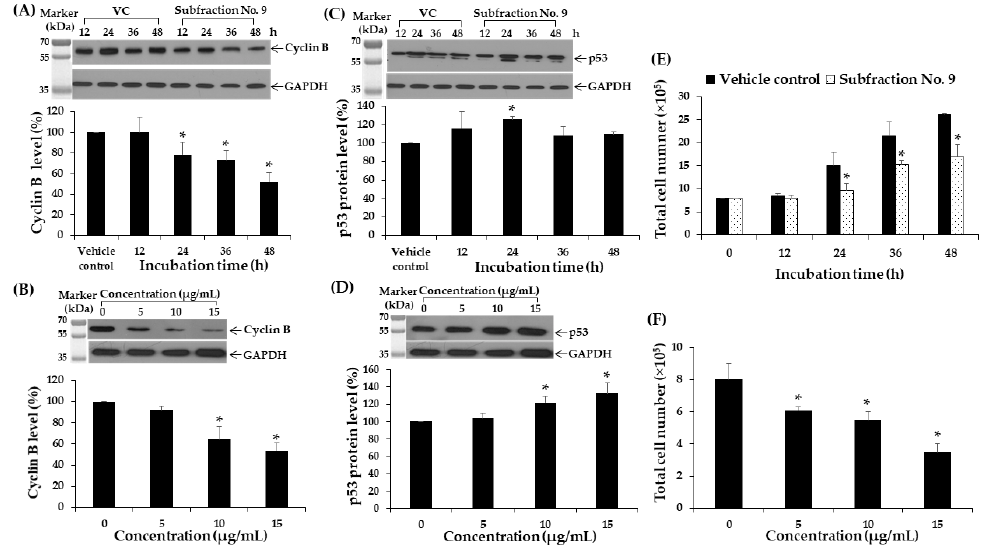
Figure 6. Effects of F9 on cyclin B and p53 proteins in K562 cells. The levels of ( A ) cyclin B after treatment with 10 µg/mL F9 for 12, 24, 36, and 48 h and ( B ) cyclin B after treatment with 5, 10, and 15 10 µg/mL for 48 h. The levels of ( C ) p53 after treatment with 10 µg/mL F9 for 12, 24, 36, and 48 h and ( D ) p53 after treatment with 5, 10, and 15 10 µg/mL for 24 h. Protein levels were assessed by Western blotting. GAPDH was used as a loading control. Protein levels were analyzed with a scan densitometer and normalized using GAPDH protein. ( E , F ) Total cell number after treatments with different contact times (12, 24, 36, and 48 h) and concentrations (5, 10, and 15 µg/mL) determined by trypan blue exclusion method. Data are expressed as mean ± SD of three independent experiments. Asterisk (*) denotes a significant difference from the vehicle control group ( p < 0.05).